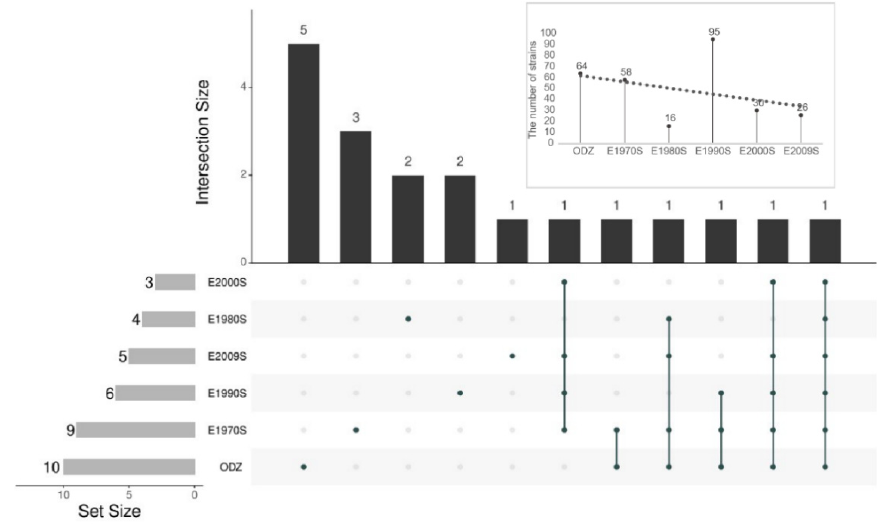
Figure 4. The Upset plot of endophytic bacteria from nine halophytes at the genus level.